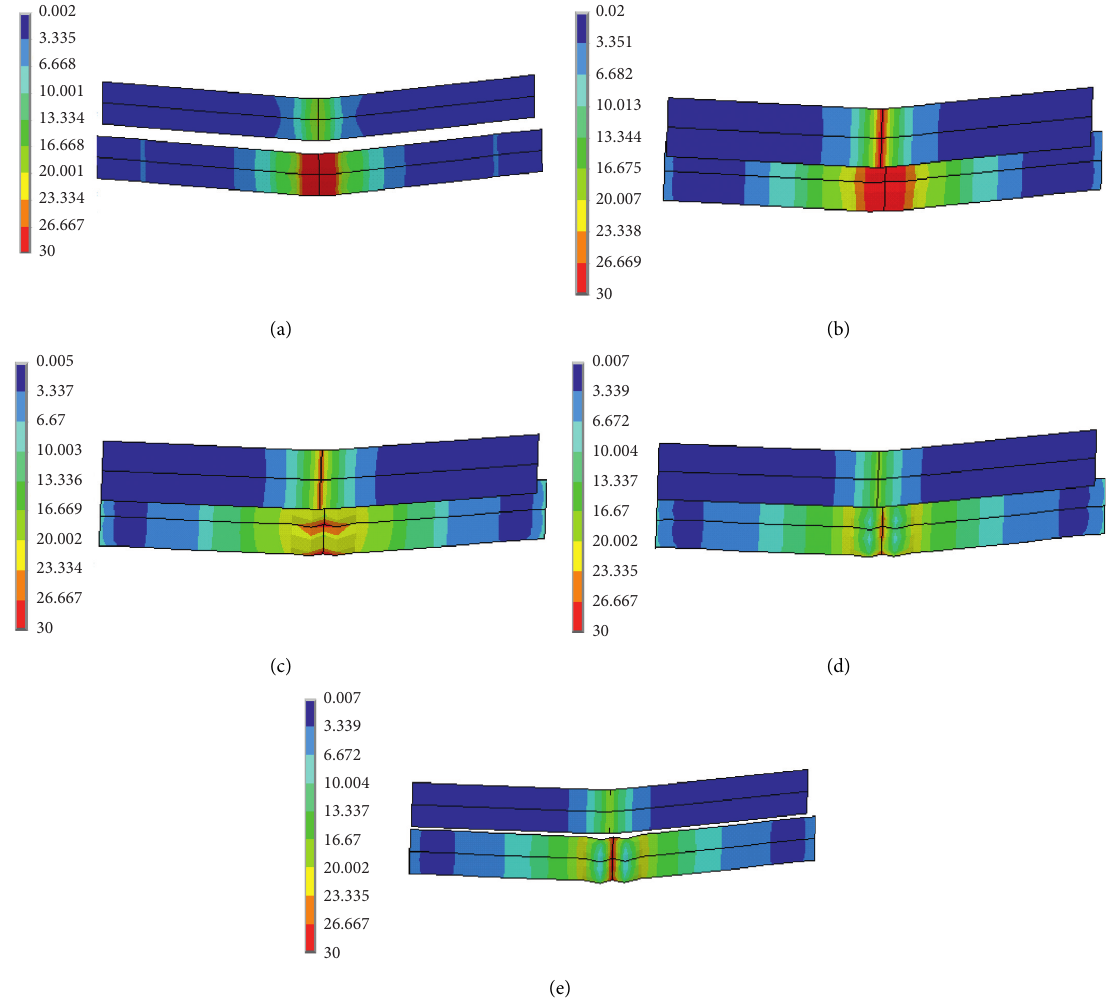
Figure 28: The stress distribution of steel plates when the thickness is changed. (a) The thickness of steel plate is 4.5 mm. (b) The thickness of steel plate is 6.5 mm. (c) The thickness of steel plate is 8.5 mm. (d) The thickness of steel plate is 10.5 mm. (e) The thickness of steel plate is 12.5